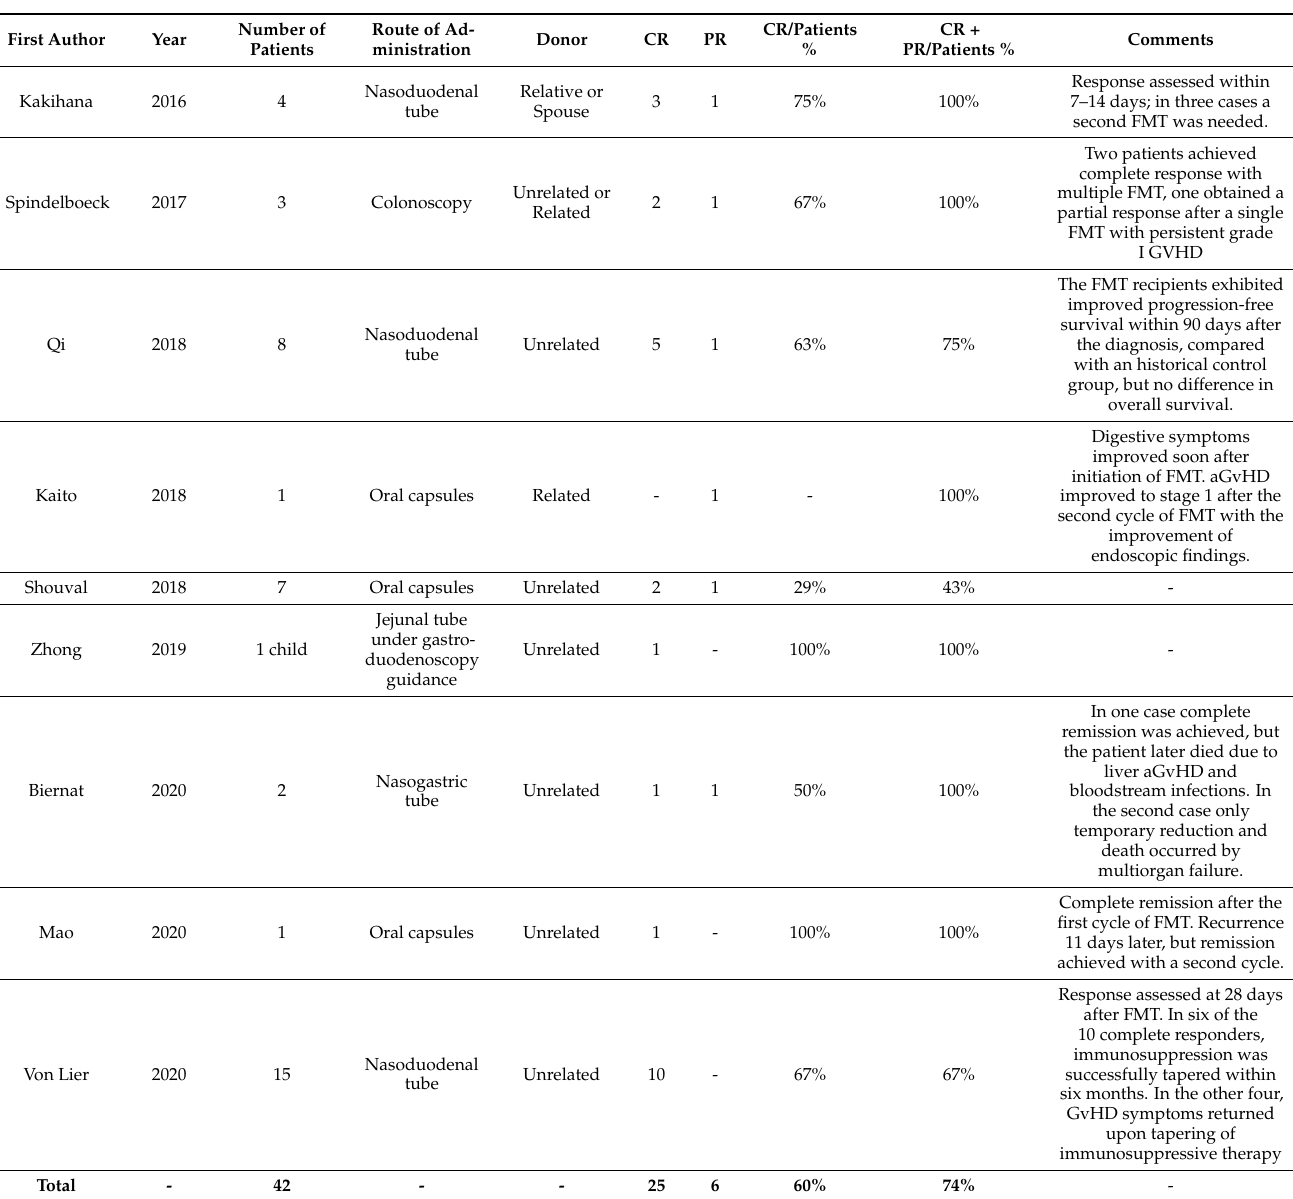
Table 1. Summary of included studies regarding FMT as a therapeutic strategy for steroid-refractory or dependent gut